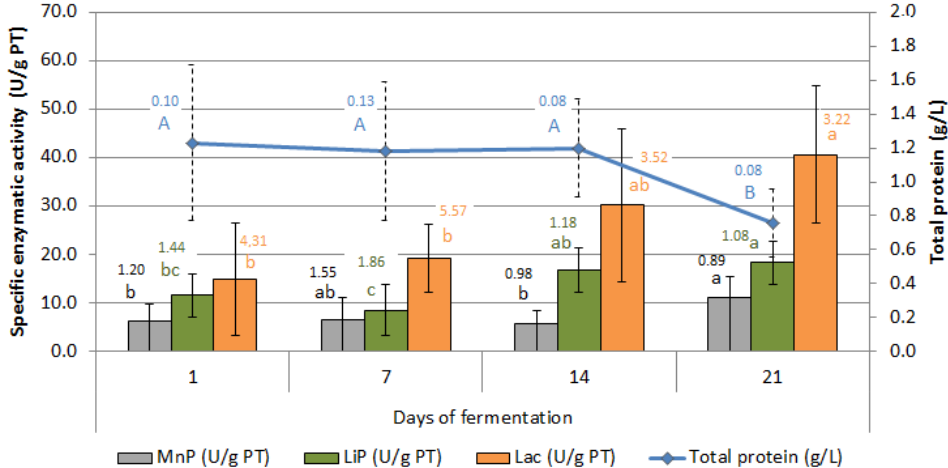
Figure 8. Specific enzyme activity (U/g PT) of manganese peroxidase (MnP), lignin peroxidase (LiP) and lacase (Lac) and total protein concentration (g/L), in SSF with P. ostreatus for 21 days. Differences were assessed by ANOVA with Tukey mean comparison test. Graph bars with different superscripts (a, b) indicate significant differences between fermentation days ( p < 0.05). Capital letters on the secondary axis of the total protein indicate significant differences between the days of fermentation ( p < 0.05). Above the superscripts of the bars and the capital letters of the secondary axis, the standard error of the mean is indicated.